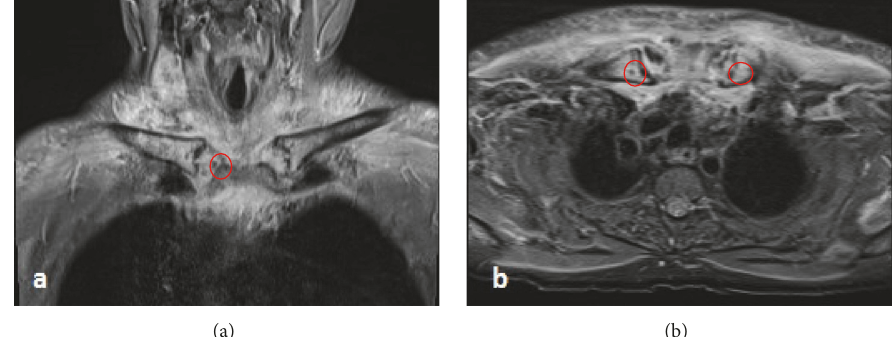
Figure 3: Sternoclavicular joints MRI scan STIR sequence. (a) Coronal image; (b) axial image showing moderate bone marrow edema in the medial third of the clavicles bilaterally, extending to the subarticular region. There was fluid signal in the SCJ space with mild to moderate marrow edema seen in the manubrium. No radiological signs of osteomyelitis were noted.